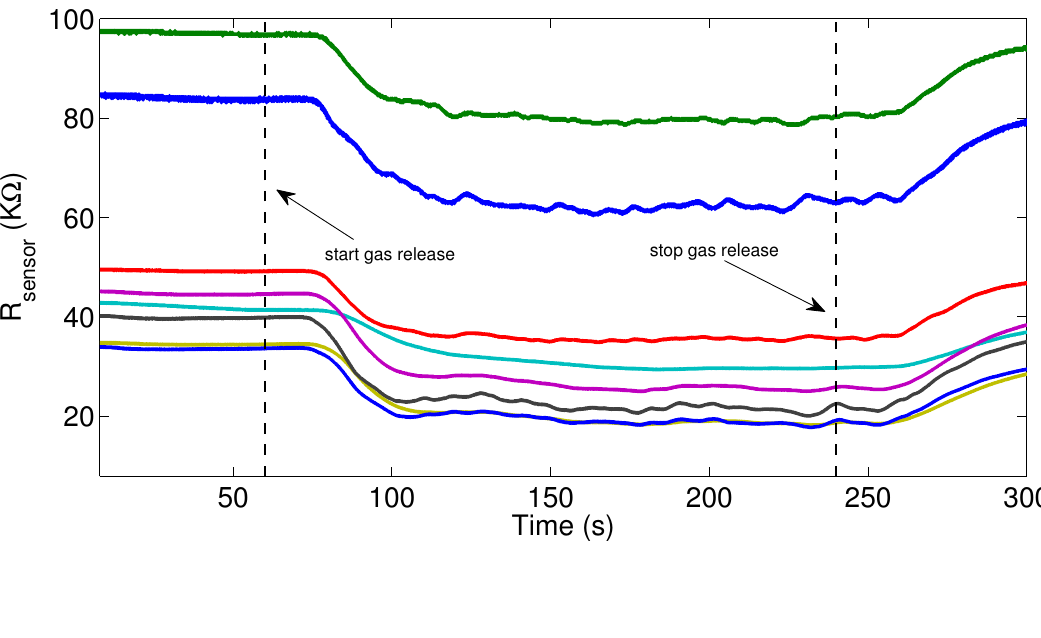
= 60 s and stopped at t = 240 s. The total 0 1